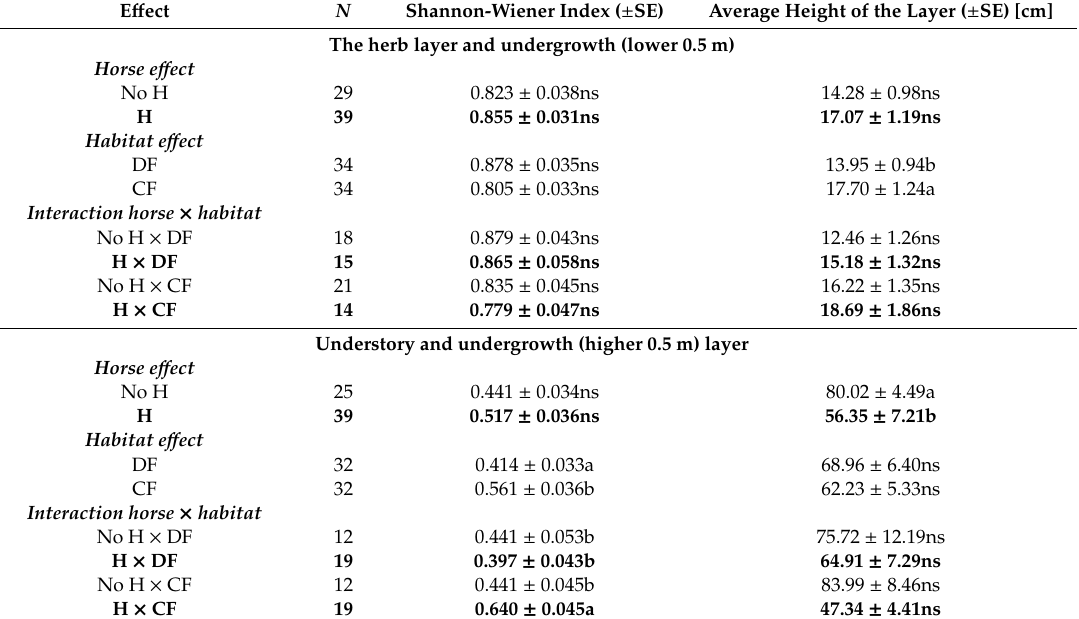
Table 2. The values of the Shannon-Wiener index ( ± SE) and average heights ( ± SE) calculated for the lower layers of forest vegetation (undergrowth higher than 0.5 m, and understory layers), in relation to the habitat fertility group and the presence of the Polish primitive horse. The means with statistically significant di ff erences ( p < 0.05) are marked with a di ff erent letter. The ns abbreviation means that statistically significant di ff erences were not observed. Areas with horse were bold coded for ease of interpretation. E ff ect N Shannon-Wiener Index ( ± SE) Average Height of the Layer ( ± SE) [cm] The herb layer and undergrowth (lower 0.5 m) Horse e ff ect No H 29 0.823 ±